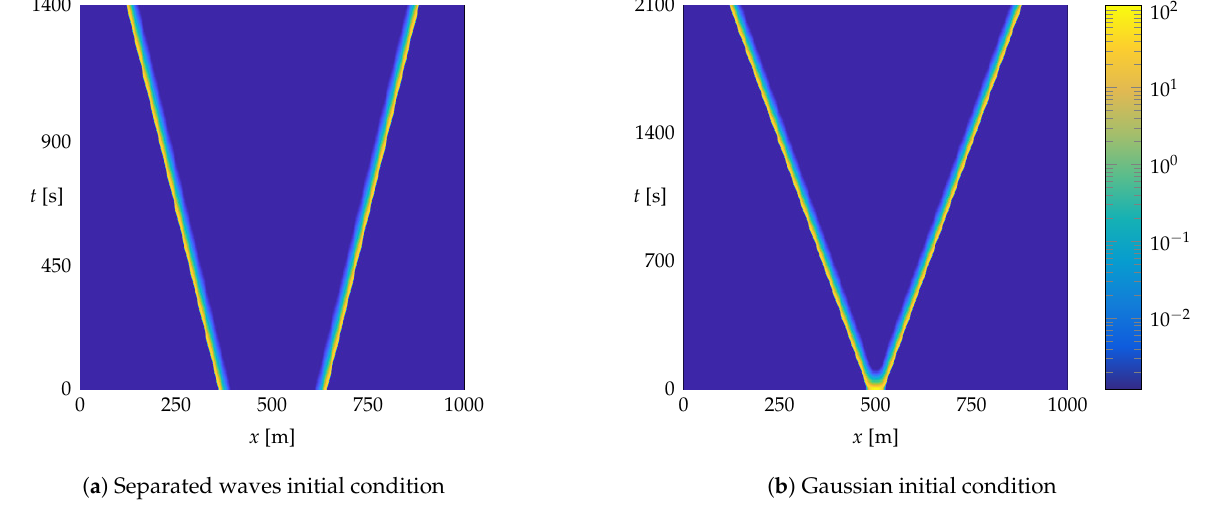
Figure 4. Snapshots of the